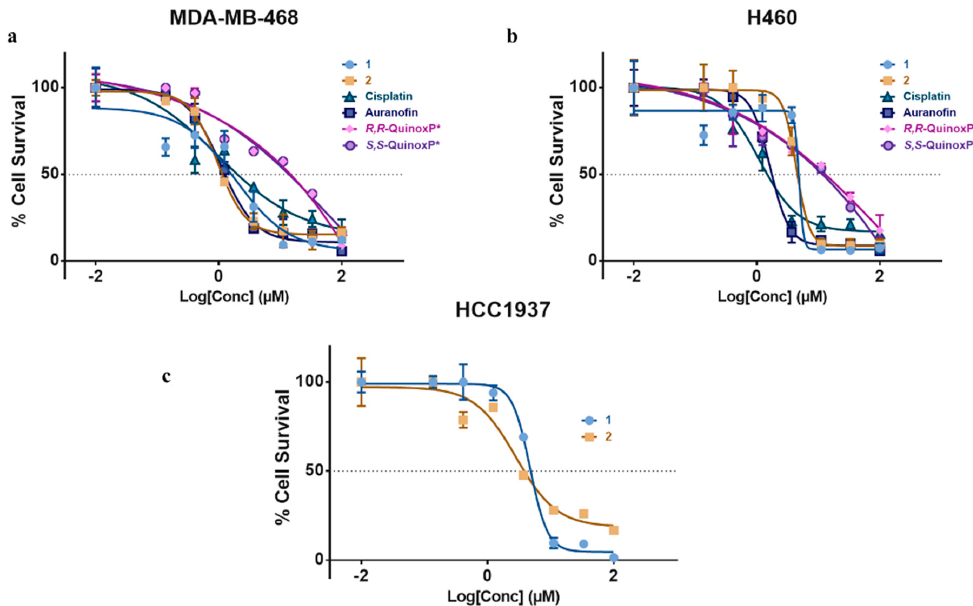
Figure 5. In vitro activity of complexes 1 and 2 , R , R -QuinoxP* and S , S -QuinoxP*, in ( a ) MDA-MB-248, ( b ) H460 and ( c ) HCC1937 cancer cell lines showing IC 50 plot for complexes after 72 h. Cell survival was determined with crystal violet assay. Data are plotted as the mean ± s.e.m (n = 3).